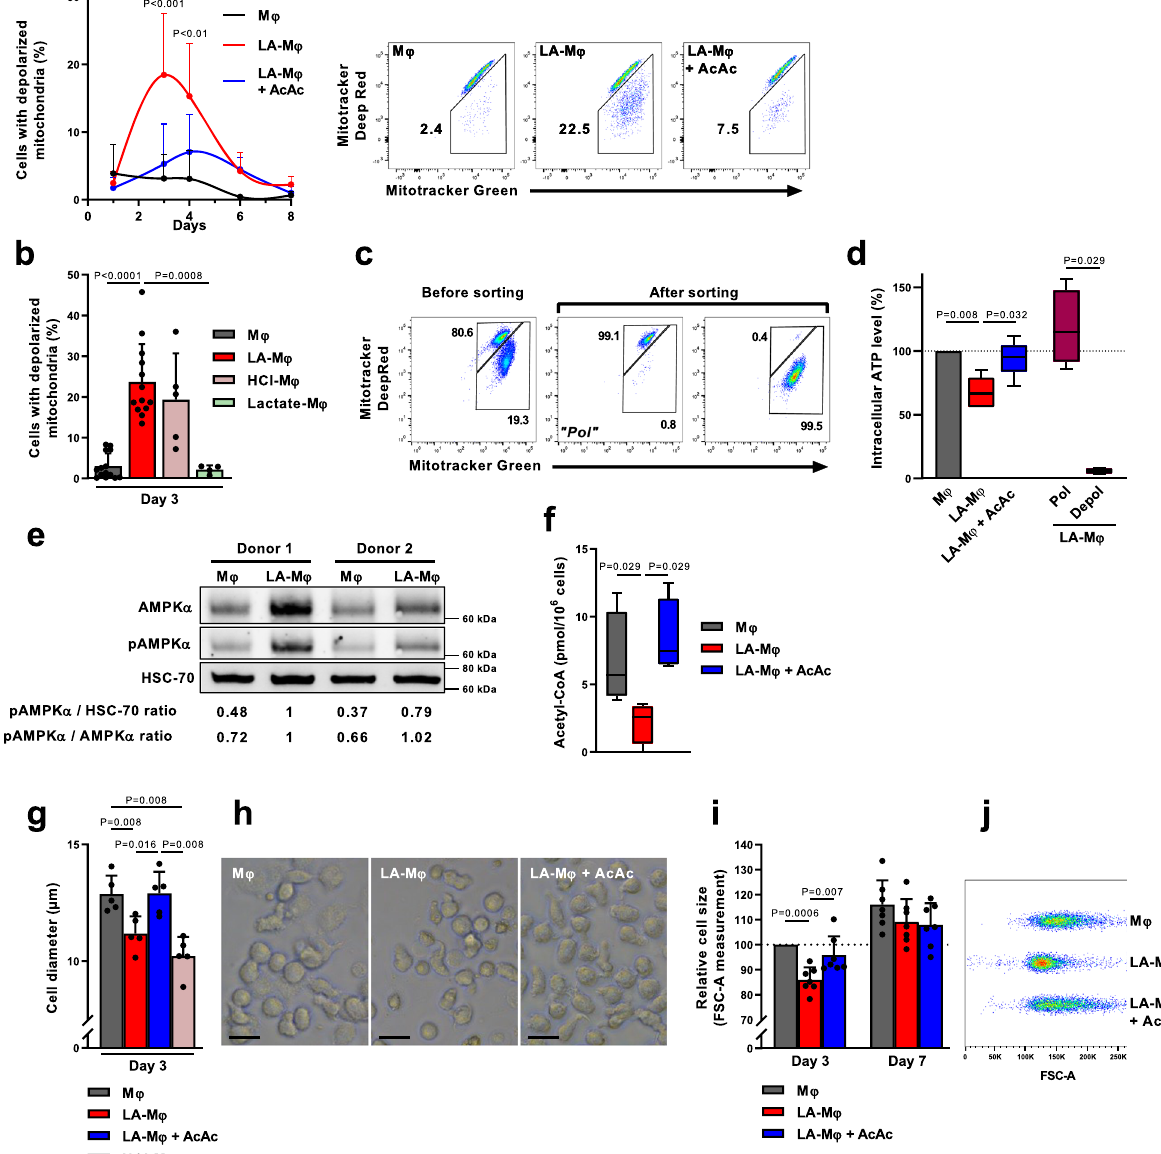
Fig. 3 Macrophages in conditions of lactic acidosis display mitochondrial depolarization and characteristics typical of starving cells. a – k Monocytes were polarized into macrophages in the absence (M φ ) or presence of lactic acid (LA-M φ ), lactic acid and acetoacetate (LA-M φ + AcAc), sodium lactate (Lactate-M φ ), or under acidosis (HCl-M φ ). a , b Cells with depolarized mitochondrial membrane potential ( ΔΨ m) were analyzed by fl ow cytometry using MitoTracker Green and MitoTracker Deep Red probes at the indicated time point ( a ) (mean ± SD; n = 4, two-way ANOVA followed by a Tukey post hoc test was performed for statistical analysis) or at day 3 ( b ) (mean ± SD; n = 14 for M φ ; n = 13 for LA-M φ ; n = 5 for HCl-M φ ; n = 4 for Lactate-M φ ). Representative dot plots on day 3 ( a , right panel). c Macrophages with or without depolarized mitochondrial membrane potential ( “ Depol ” and “ Pol ” populations, respectively) were isolated from day 3 LA-M φ by fl ow cytometry with MitoTracker Green and MitoTracker Deep Red probes. Purity was >99%. d Intracellular ATP levels were measured in a semiquantitative assay. The results were normalized against the M φ condition for each donor ( n = 5). e Levels of total AMPK α , AMPK α phosphorylated on Thr172 (pAMPK α ) and HSC-70 were analyzed by Western blotting at 6 h (representative images from four independent experiments); the values correspond to pAMPK α /HSC-70 and pAMPK α /AMPK α band intensity ratios. f Intracellular acetyl-CoA levels determined on day 3 ( n = 4). g – j Cell size was measured on day 3 ( g – j ) and day 7 ( i ), by determining the mean ± SD of the diameter of M φ in each population ( g , n = 5) or relative cell size by fl ow cytometry with the FSC-A parameter ( i , n = 7). h Photomicrographs of the M φ population on day 3 (representative images from fi ve independent experiments); size bar, 10 µ m. j Representative dot plots from one donor of FSC-A measurement. a – j The boxplots display a median line, interquartile range (IQR) boxes, min to max whiskers; a two-tailed Mann – Whitney U test was performed for statistical analysis unless speci fi ed otherwise. Source data are provided in a Source Data fi